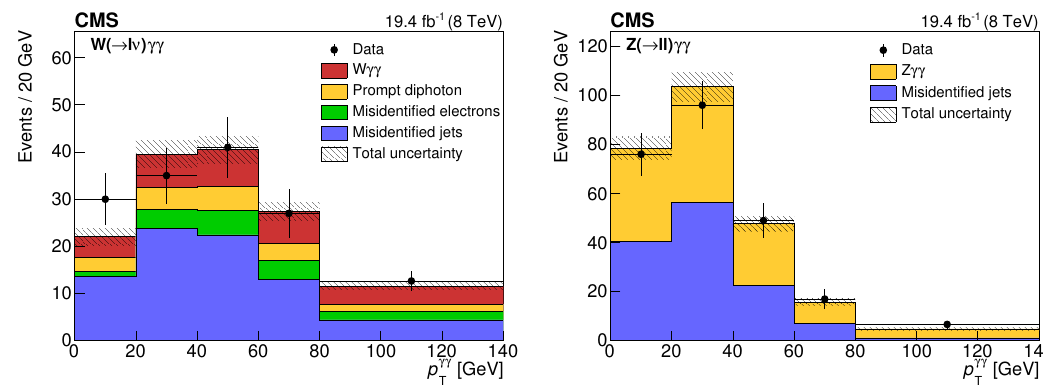
Figure 2 . Distributions of the diphoton p T for the W (cid:13)(cid:13) (left) and Z (cid:13)(cid:13) (right) analyses with the electron and muon channels summed. The points display the observed data and the histograms give the predictions for the background and signal. The indicated uncertainties in the data points are calculated using Poisson statistics. The hatched area displays the total uncertainty in the sum of these predictions. The predictions for electrons and jets misidenti(cid:12)ed as photons are obtained with data-based methods. The remaining background and signal predictions are derived from MC simulation. The last bin includes all events in which the diphoton p T exceeds 80